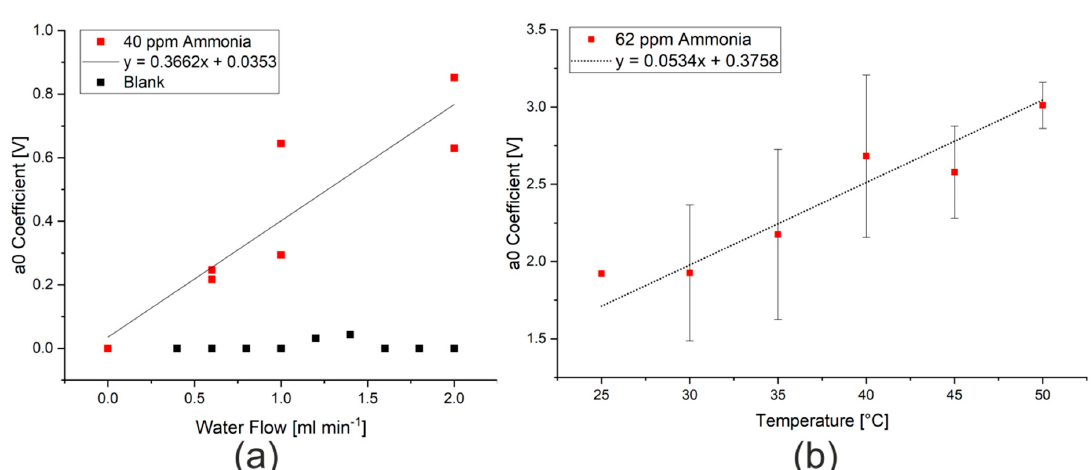
Figure 4. ( a ) Effect of water flow rate on the a 0 coefficient measured when spraying 40 ppm ammonia in Figure 4. ( a ) E ff ect of water flow rate on the a 0 coe ffi cient measured when spraying 40 ppm ammonia water. ( b ) Effect of nebulizer temperature on the a 0 coefficient measured when spraying 62 ppm in water. ( b ) E ff ect of nebulizer temperature on the a 0 coe ffi cient measured when spraying 62 ppm ammonia in water at 2 mL min − 1 . ammonia in water at 2 mL min − 1